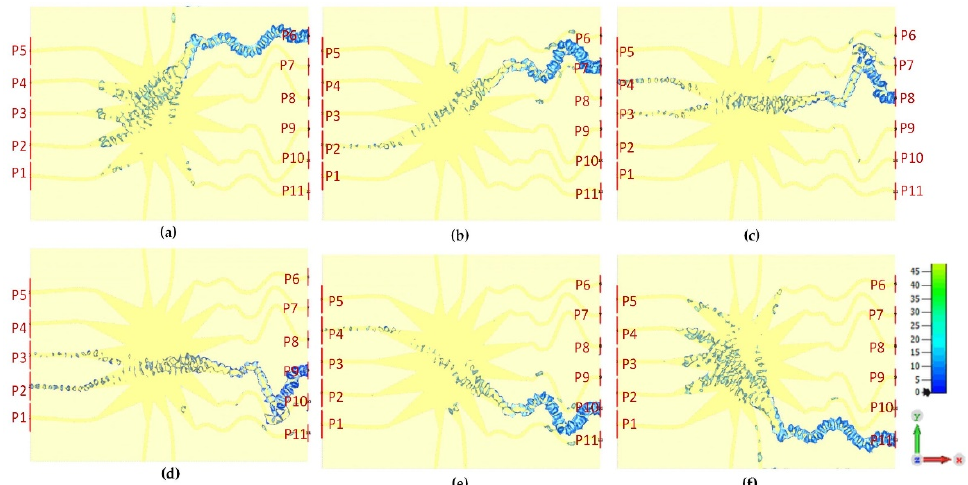
Figure 11. Surface current distributions of the array port (P6–P11), from below to above, for the proposed Rotman lens sensor; ( a ) P6 is active, ( b ) P7 is active, ( c ) P8 is active, ( d ) P9 is active, ( e ) P10 is active, ( f ) P11 is active.